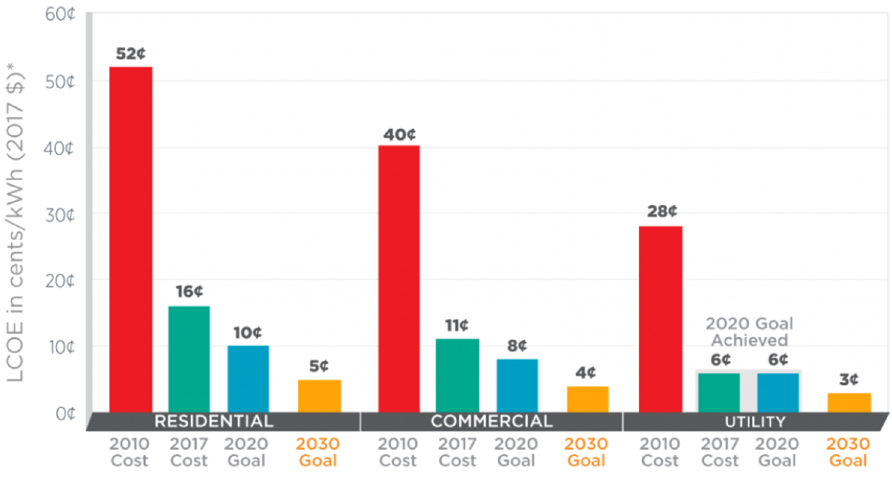
Figure 6. Targets of SunShot Initiative and goals [100]. ITC: investment tax credit.